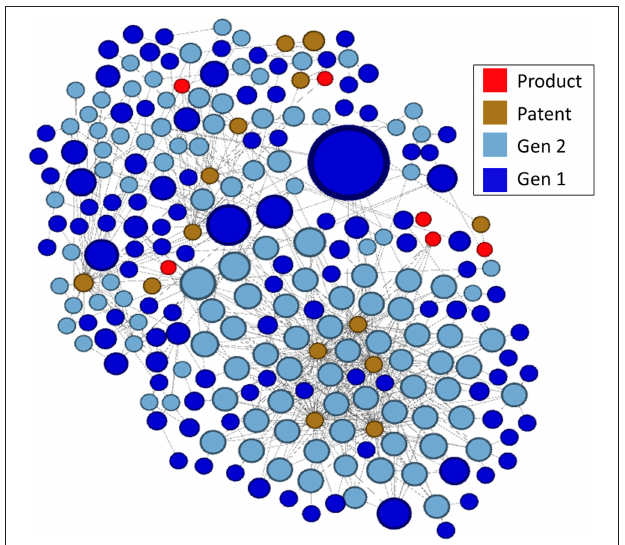
FIGURE 8 | Highly linked cluster shown in Figure 7 , by type of node.